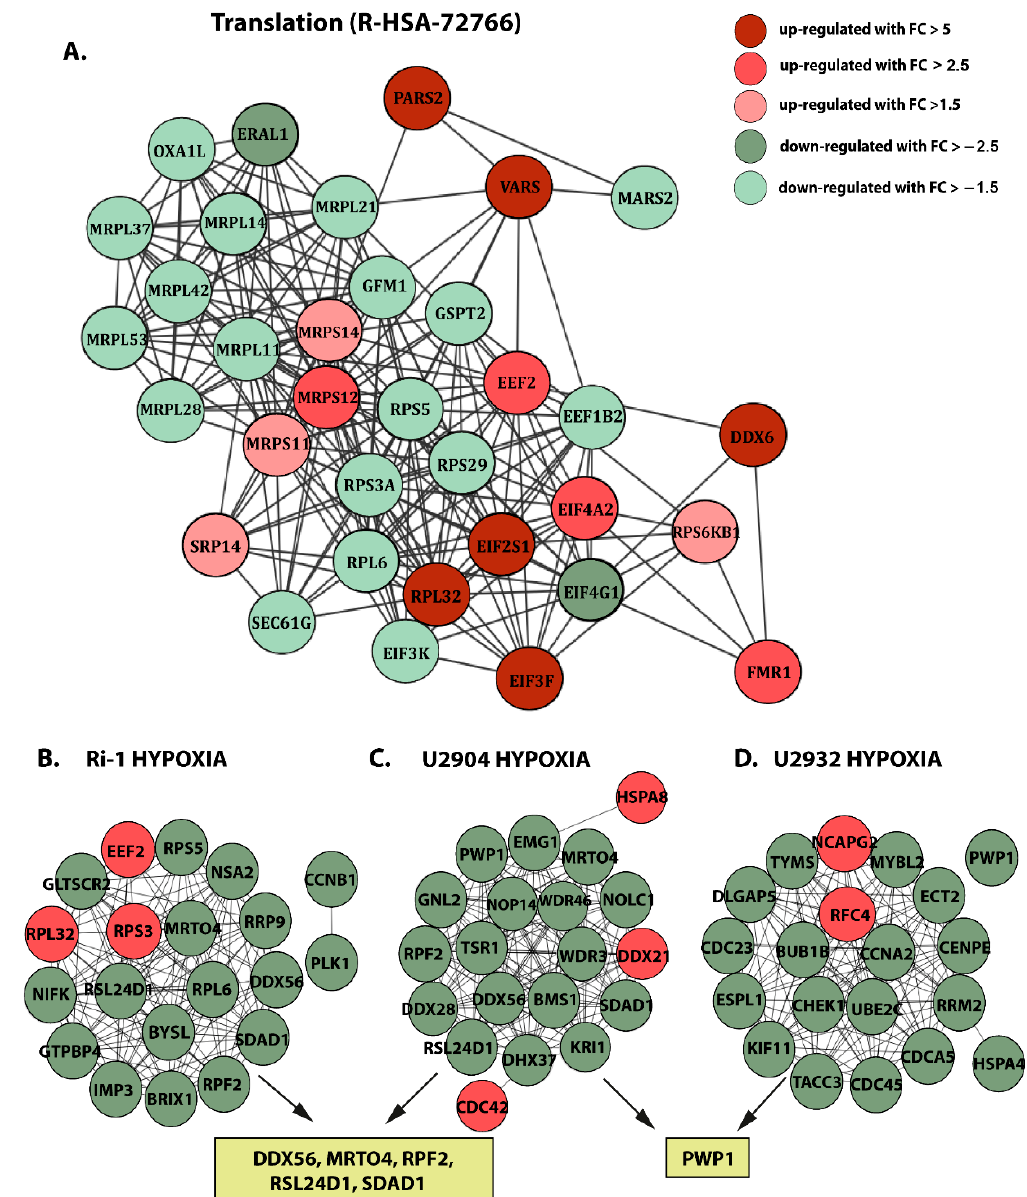
Figure 8. ( A ) Protein–protein interaction network of DAPs identified in Ri-1 cells under hypoxia related to translation (R-HSA-72766). Generated using the stringApp from Cytoscape. ( B ) Top 20 hub proteins identified in hypoxic Ri-1, ( C ) U2904, and ( D ) U2932 cell lines based on the highest degree score. Analyzed and generated using the cytoHubba app from Cytoscape. Red and green nodes represent up- and downregulated proteins, respectively.